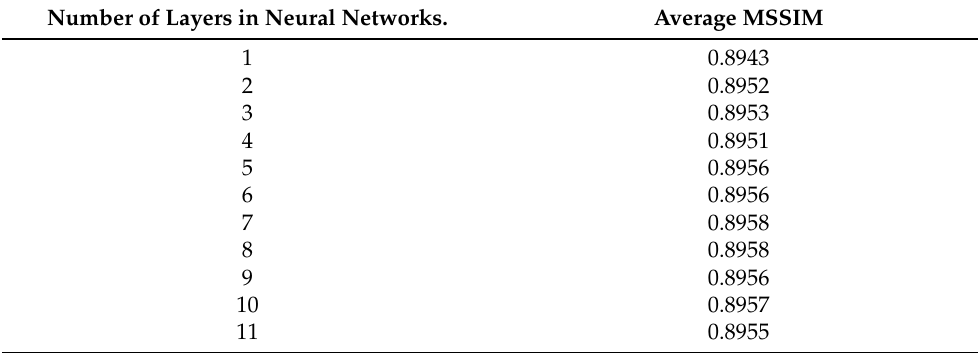
Table 2. Average MSSIM for different numbers of layers in wide residual neural networks. Number of Layers in Neural Networks.